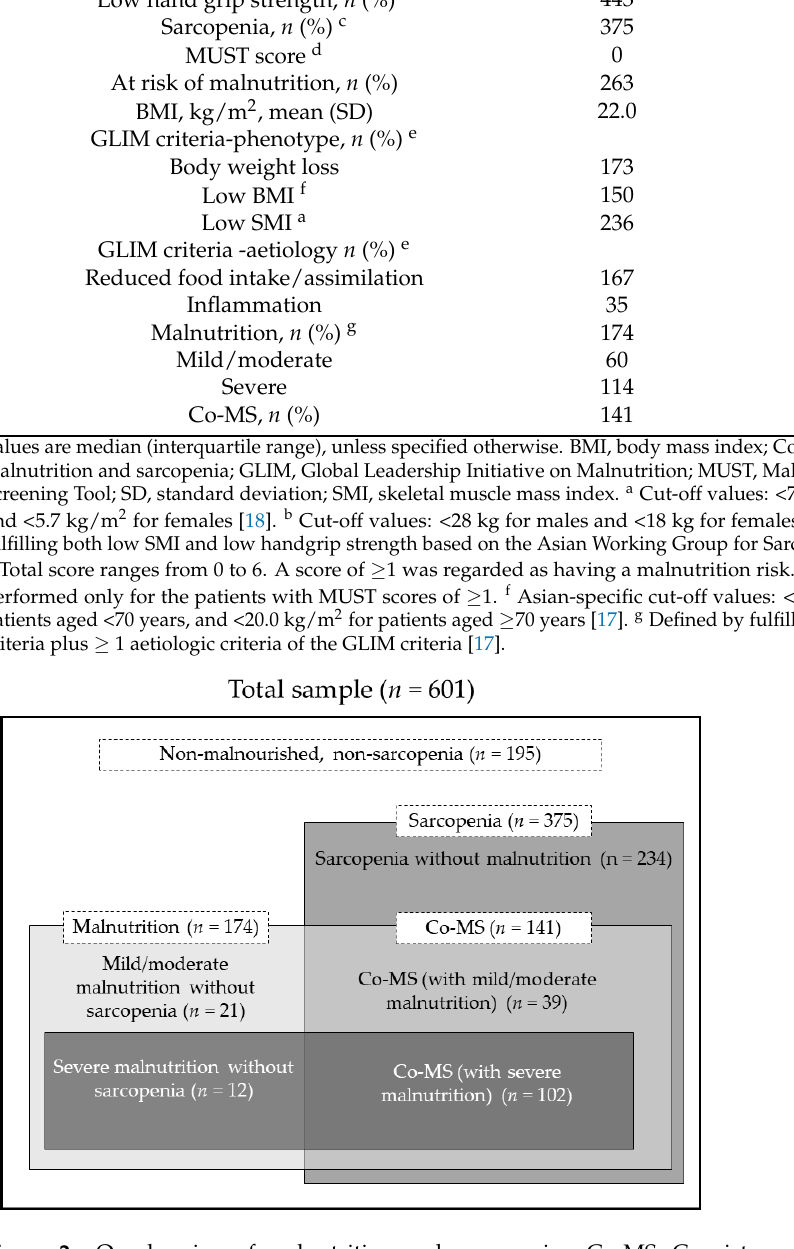
Table 2. Prevalence of malnutrition, sarcopenia, and coexistence of malnutrition and sarcopenia (Co-MS) in 601 patients admitted to the convalescent rehabilitation wards.